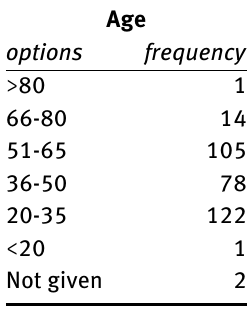
Table 2: Frequency distribution of subjects’ age